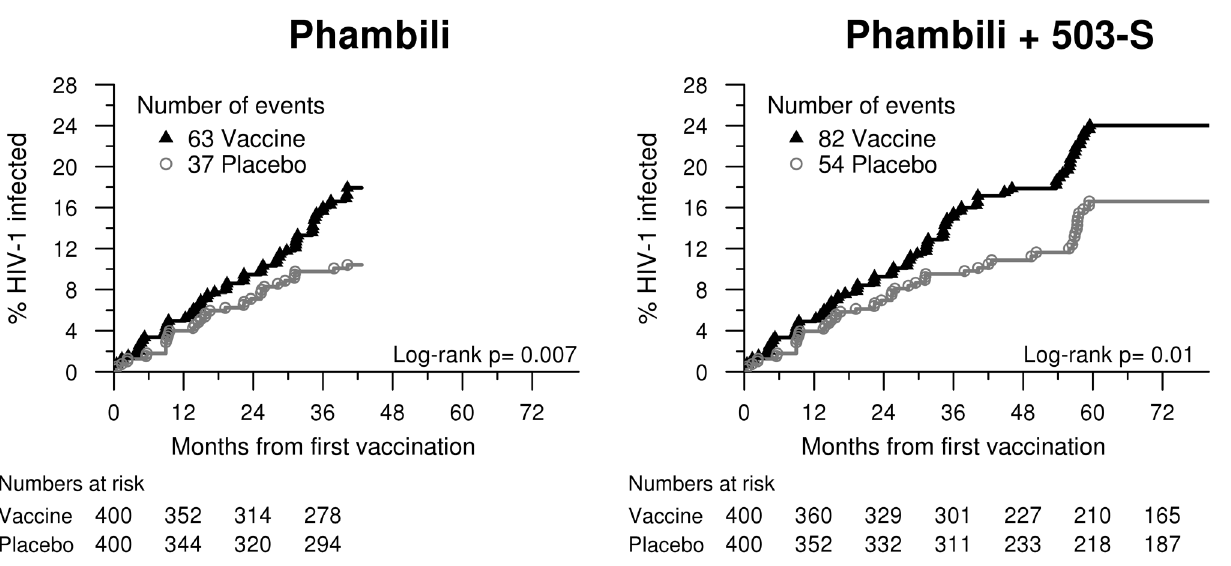
Fig 1. Cumulative HIV-1 incidence curves for vaccine and placebo groups for Phambili and Phambili + HVTN 503-S follow-up; Phambili + HVTN 503-S curves are based on all MITT Phambili participants (n = 800) with updated HIV-1 status for the subset of participants enrolled in HVTN 503-S (n = 465).